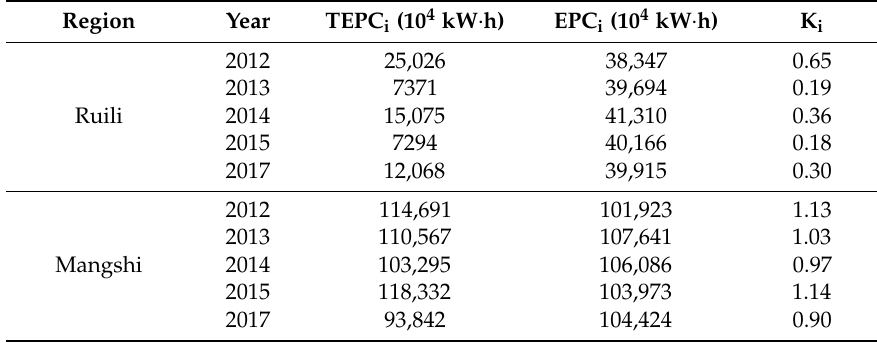
Table 7. Correction factor